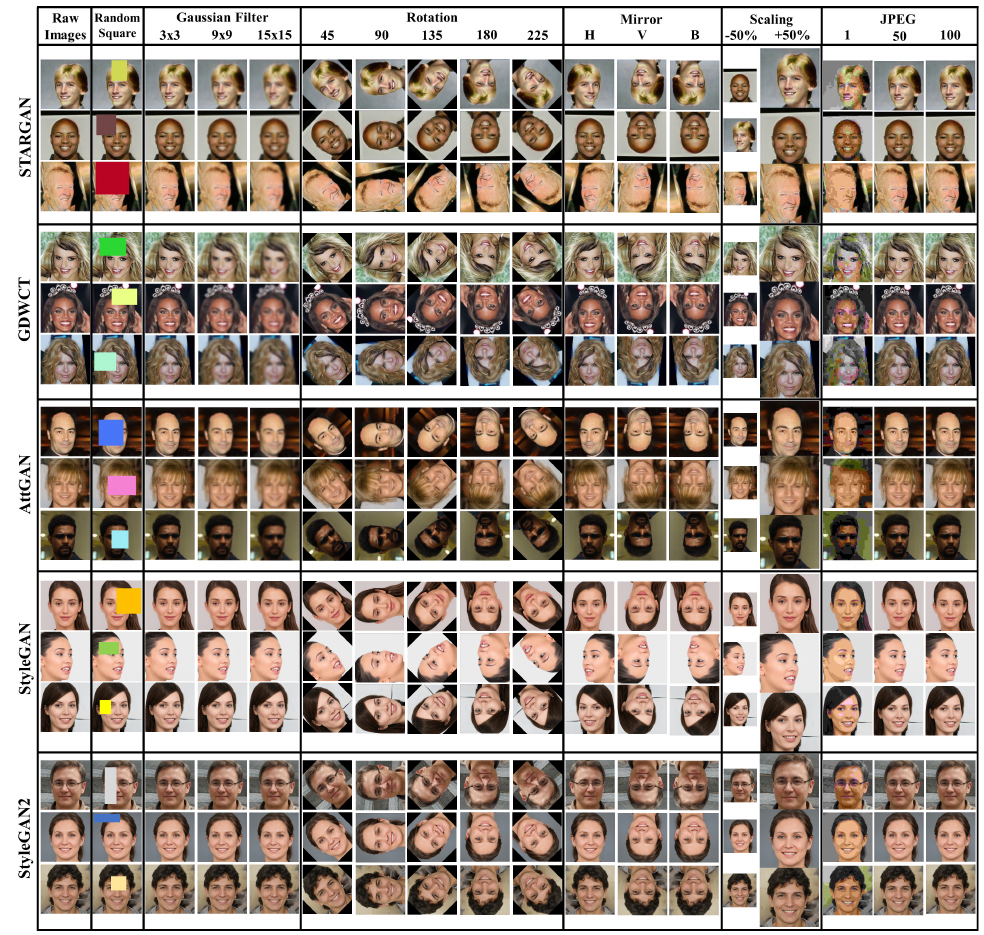
Figure 9. Examples of ATTGAN, GDWCT, STARGAN, STYLEGAN, STYLEGAN2 images in which we applied different attacks: Random Square, Gaussian Blur, Rotation, Mirror, Scaling and JPEG Compression. They were also applied in the real dataset (CelebA and